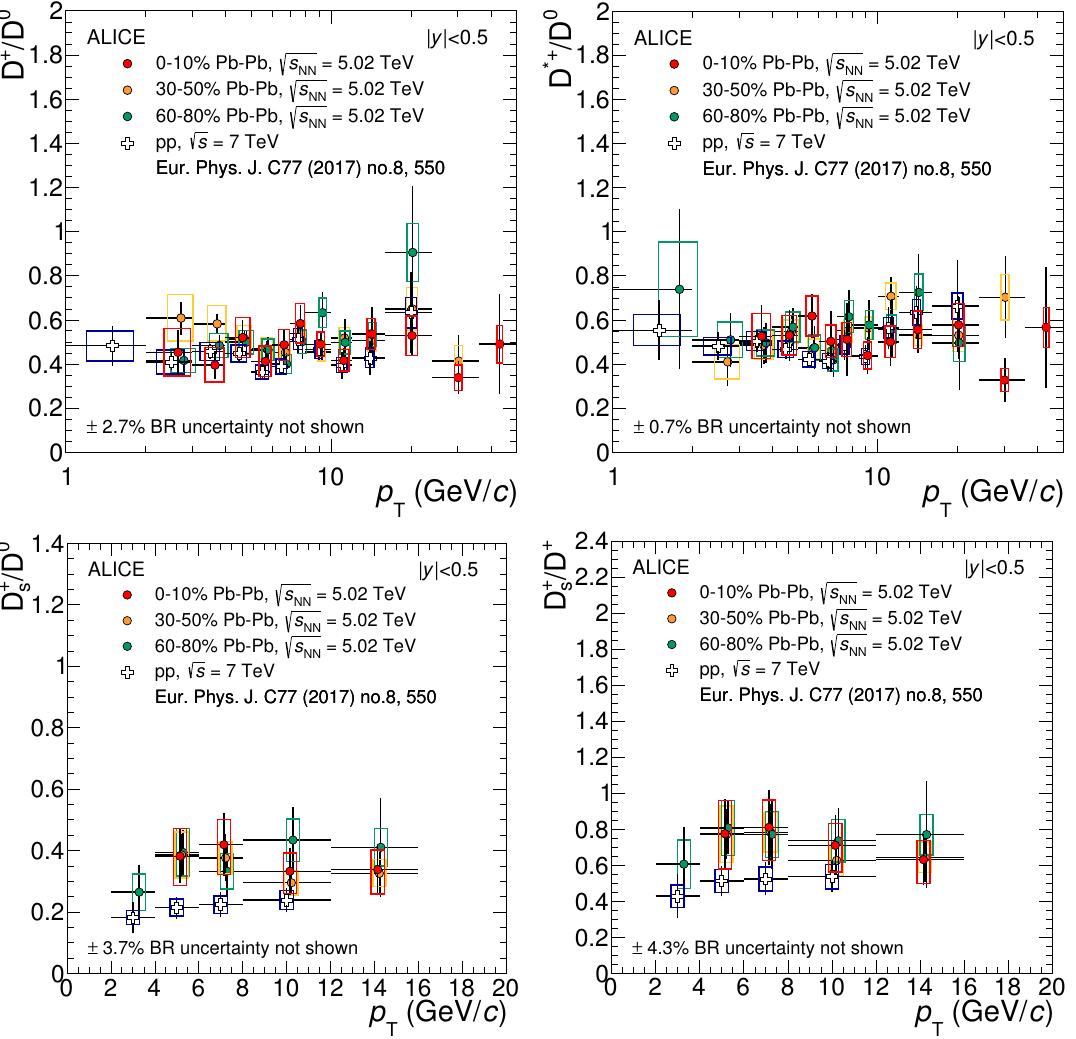
Figure 4 . Ratio of prompt D-meson yields as a function of p T . Statistical (bars) and systematic (boxes) uncertainties are